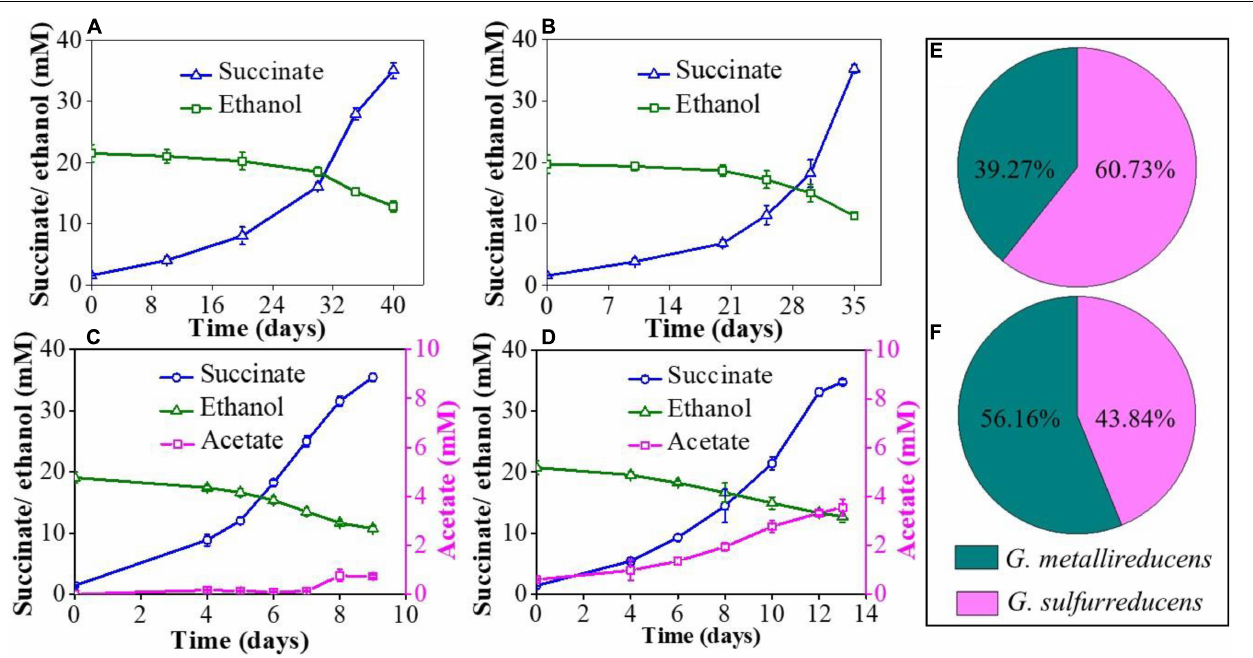
FIGURE 1 | Ethanol consumption, acetate accumulation, and succinate production: (A) the GS15 and PCA co-culture in the first generation; (B) the GS15 and PCA (cid:49) 1501 co-culture in the first generation; (C) the GS15 and PCA co-culture in the metabolic stable period; and (D) the GS15 and PCA (cid:49) 1501 co-culture in the metabolic stable period. The proportion of GS15 and PCA in the co-cultures: (E) the GS15 and PCA co-culture in the metabolic stable period; (F) the GS15 and PCA (cid:49) 1501 co-culture in the metabolic stable period.